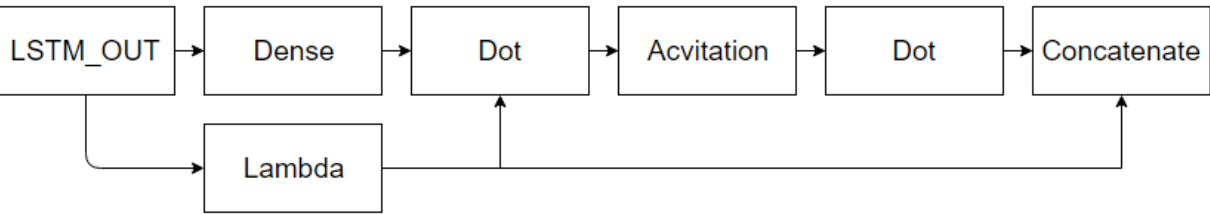
Figure 3. The overall architecture of the proposed global attention.